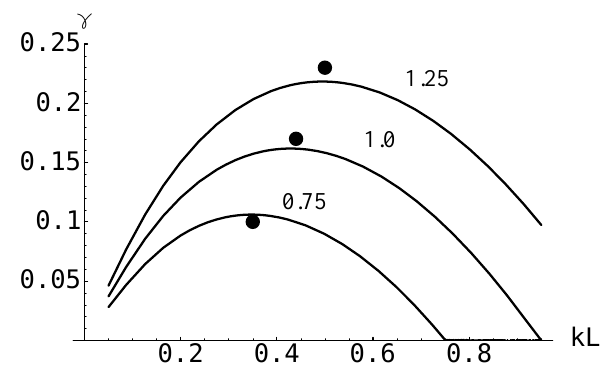
Fig. 4. Normalized growth rate γ (scaled to V ◦ /L ) versus normal- ized wavenumber kL given u =2 and ν ◦ =2 for three different values of ν 1 . The points represent (9) evaluated at the value of k x indicated and with k z =1.25 (see